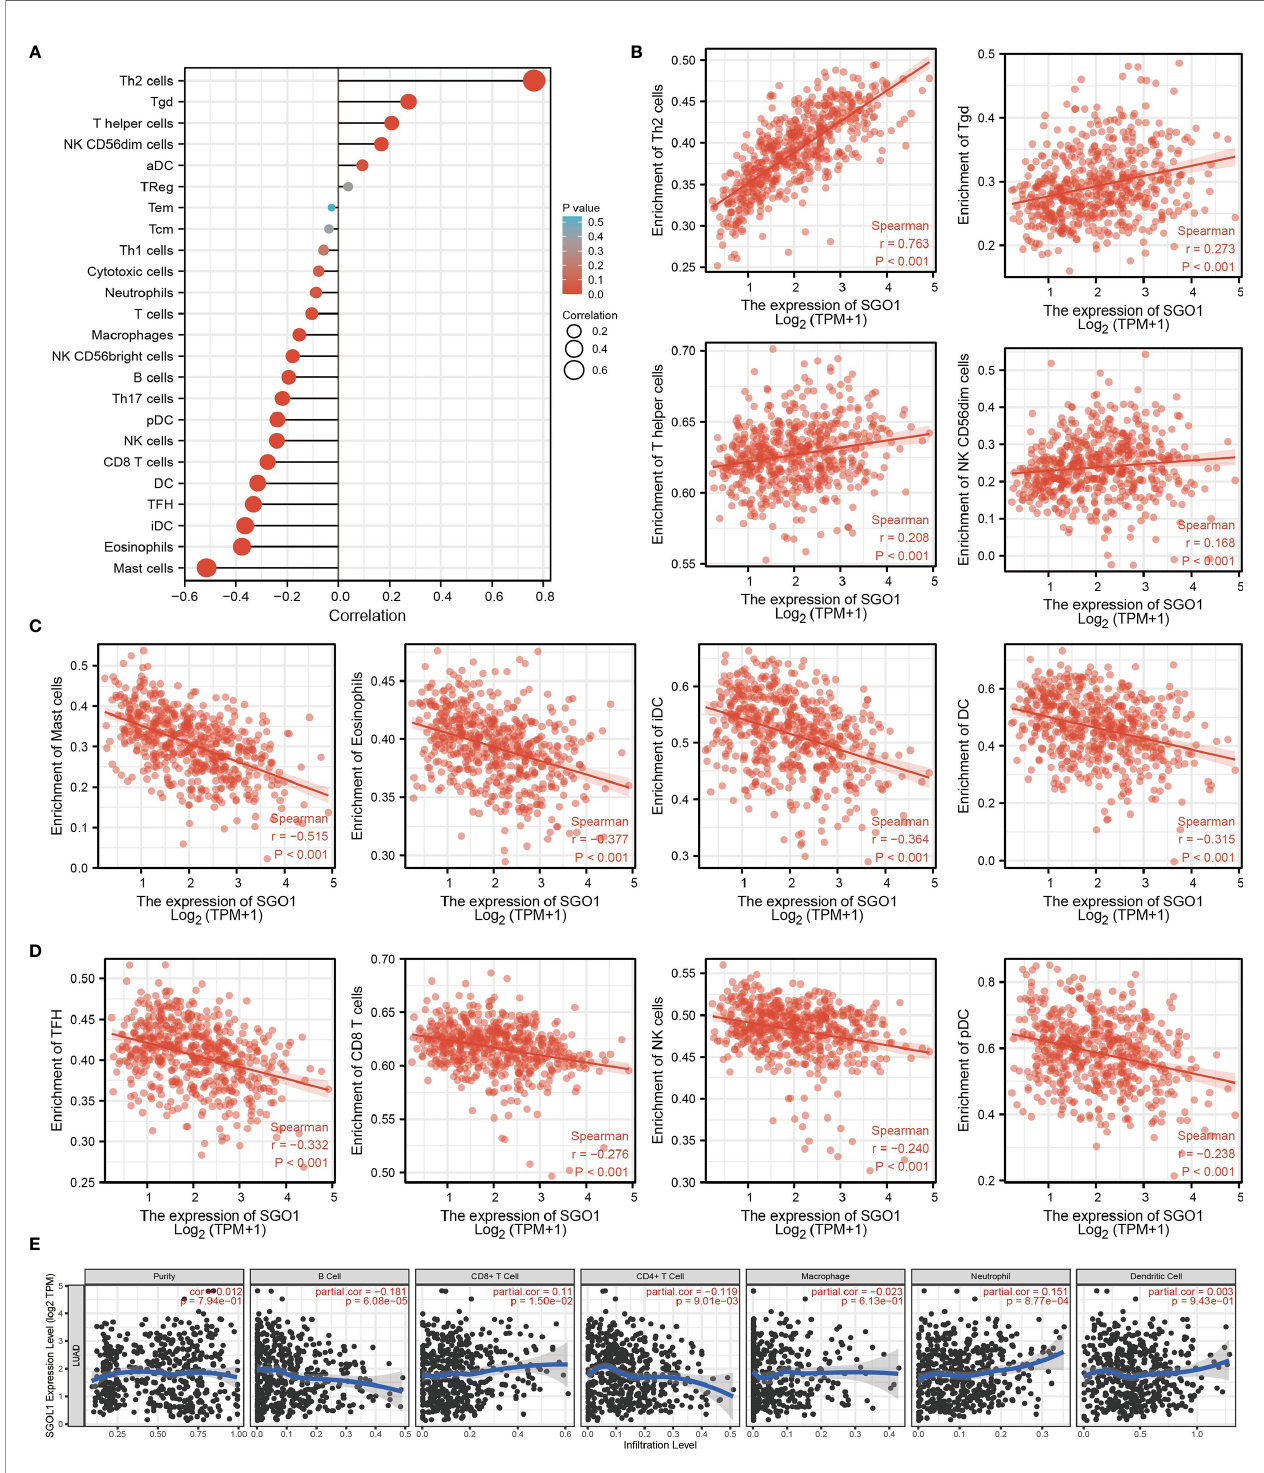
FIGURE 8 | Correlation analysis of SGO1 expression and in fi ltration levels of immune cells in LUAD. (A – D) The correlation between SGO1 expression and the in fi ltration levels of 24 immune cells in LUAD. (E) Correlation of SGO1 expression with immune in fi ltration in